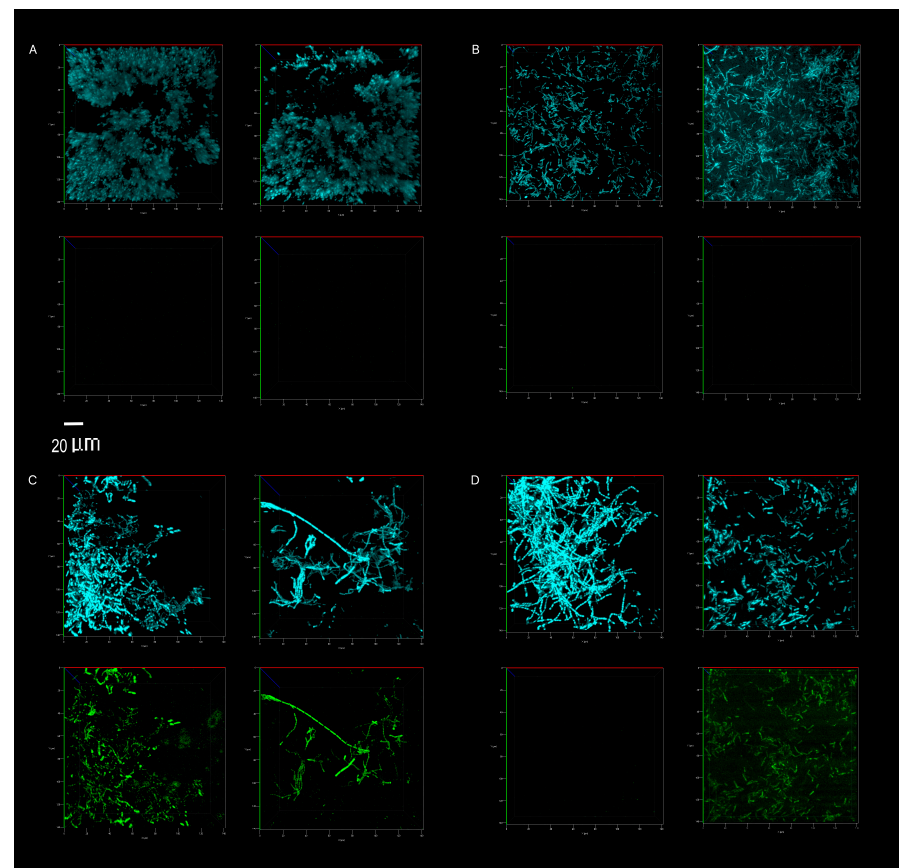
Figure 6. Direct visualization, using confocal microscopy, of the total microbiome (top panel of each image, blue) and P. aeruginosa (bottom panel of each image, green). Abundance on indoor linoleum squares was compared for tap water control ( A ), plain soap ( B ), disinfectant ( C ) and probiotic cleaner ( D ) treatments. The left and right sections of each panel ( A – D ) represent biological replicates, images of two separate flow cells per treatment. The 20 µ m scale bar applies to all 16